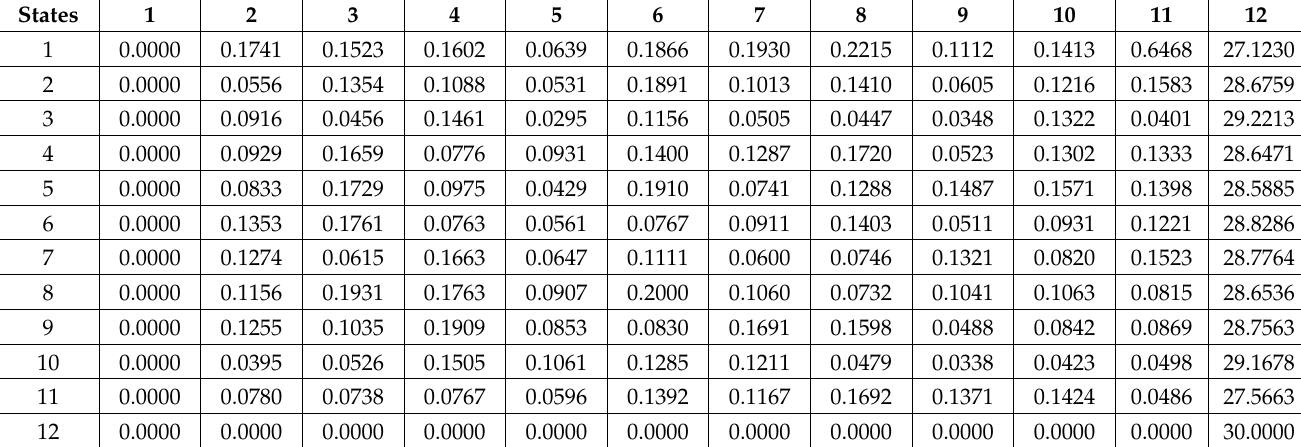
Table 3. Matrix v ij , the expected number of visits to each state of the process. Source: Authors’ own elaboration.